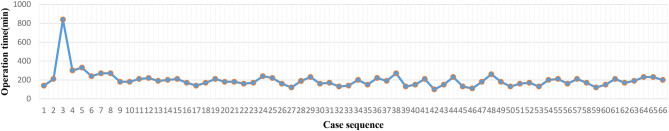
Graph of operative times plotted for each robotic NOSES for Prof. Li.